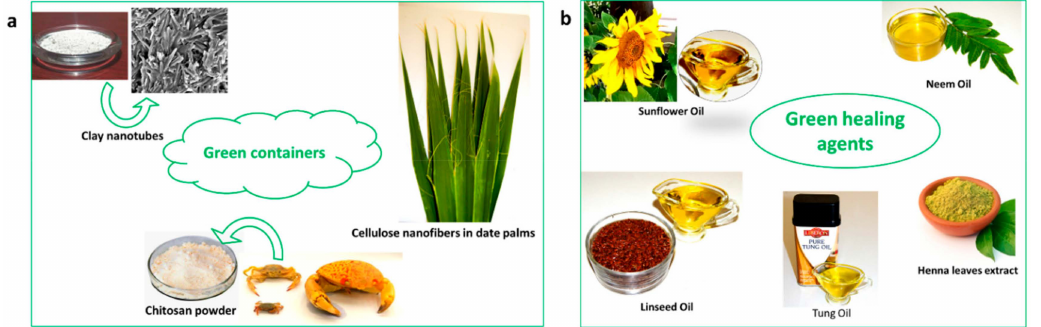
Figure 4. The green components of self-healing anticorrosive